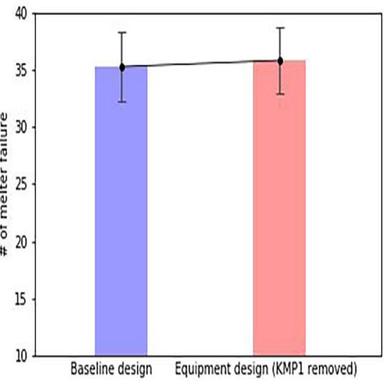
The average total numbers of melter failures during the operation time are 35 and 36, respectively, for the baseline design and the equipment design. Both standard deviations are about 3 times.